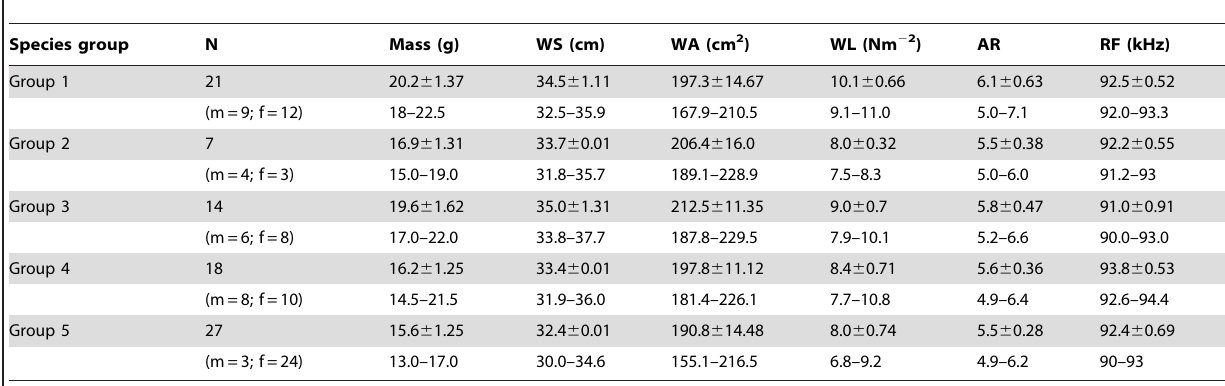
Table 5. Size, wing and echolocation parameters (mean 6 SD; minimum–maximum) for the total number of bats in each of the five groups (see Fig. 2 tree).